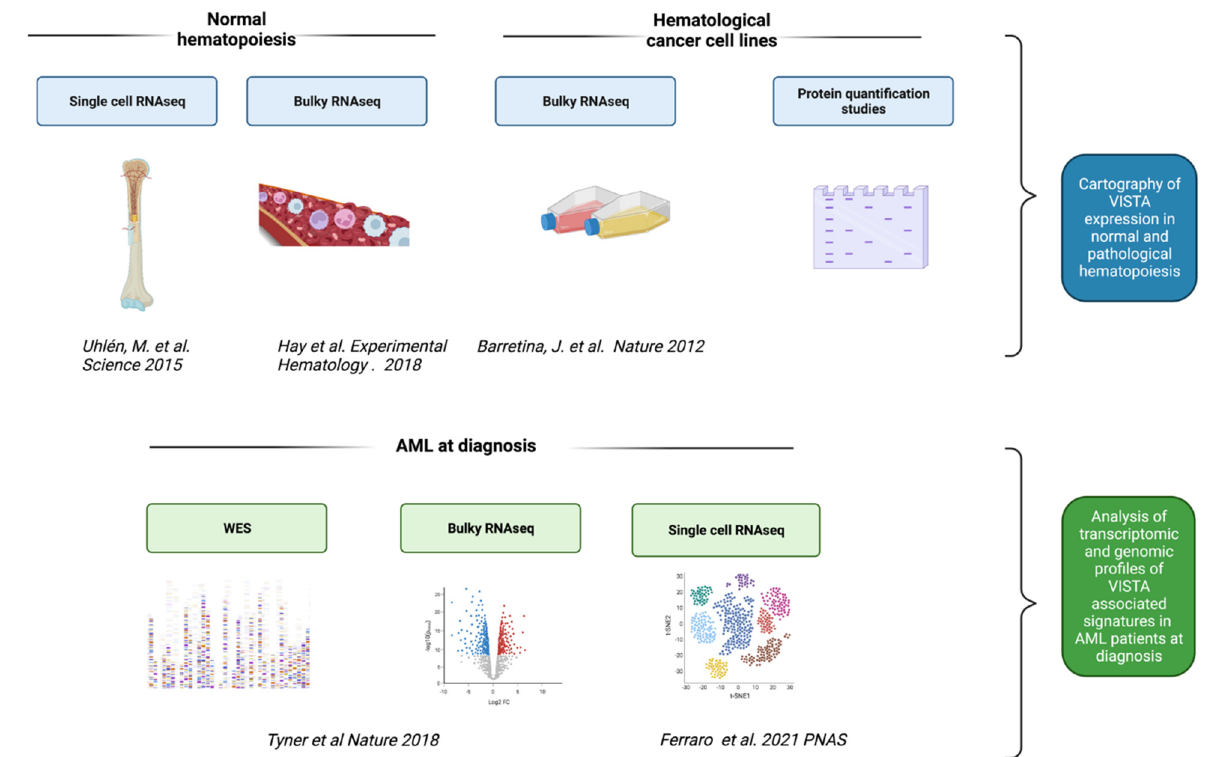
Figure 1. Flow chart showing the study design . We determined a cartography of VISTA expression across normal hematopoiesis stages and hematological cancer cell lines by integrating multiple transcriptomic data from public resources and protein quantification studies. Then, we analyzed the transcriptomic and genomic profiles of VISTA associated signatures in acute myeloid leukemia (AML) cases at diagnosis. Next, we analyzed single-cell RNAseq data from an independent cohort of patients with normal karyotype AML, treated homogeneously with standard induction and consolidation chemotherapy and with well-annotated remission data after treatment. We then compared phenotypic data to understand the interplay between AML and T cells with regard to VISTA expression. Parts of the figure were created with BioRender.com [5,16–19].